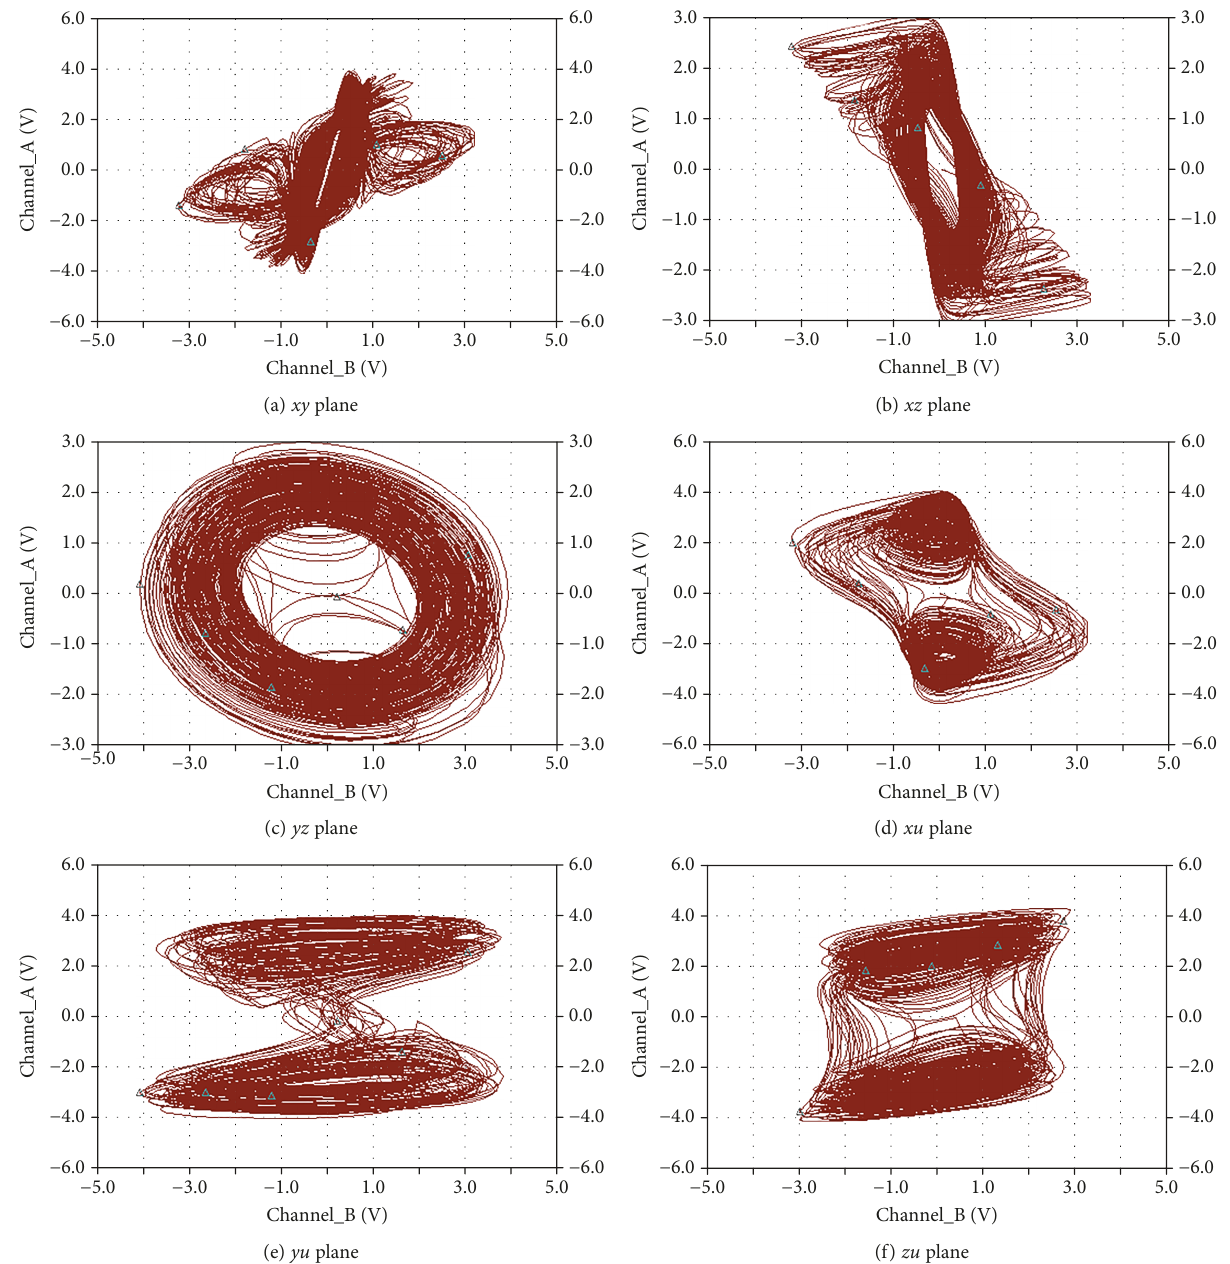
Figure 11: The chaotic attractors of the novel memductor-based chaotic circuit with